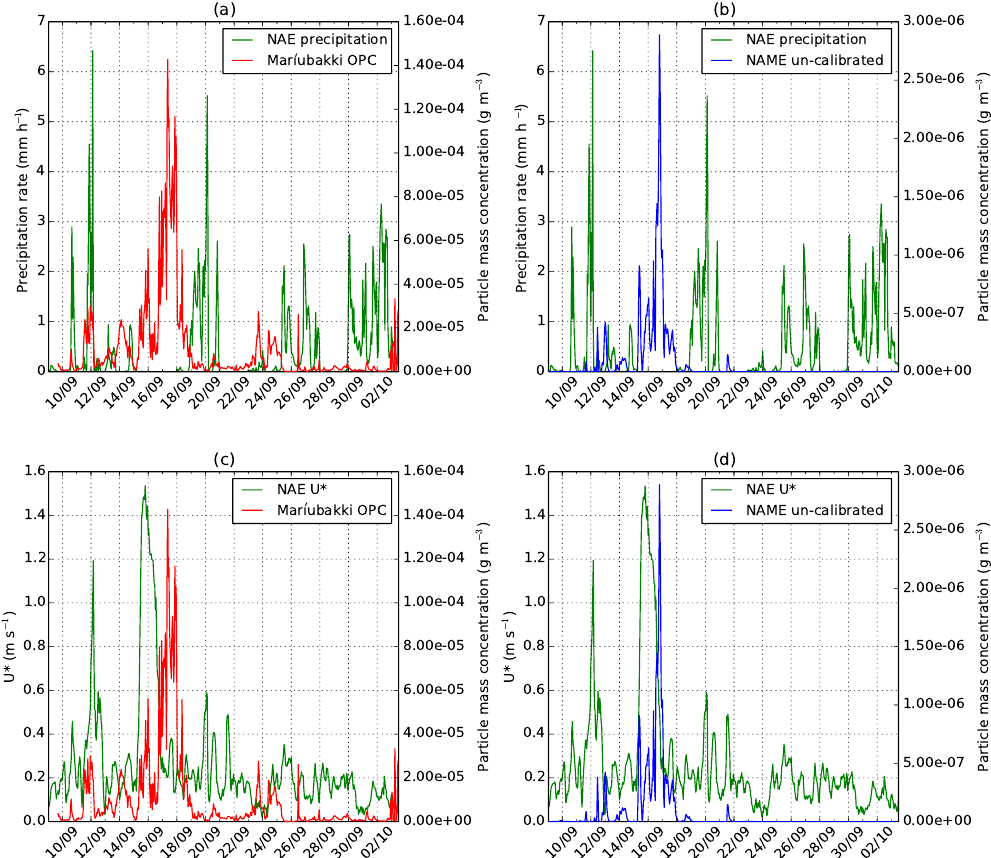
Figure 6. Time series of 1h averaged air concentrations of resuspended ash derived from OPC count data and the un-calibrated model output, compared to the NAE precipitation rate and friction velocity ( U ∗ ) at